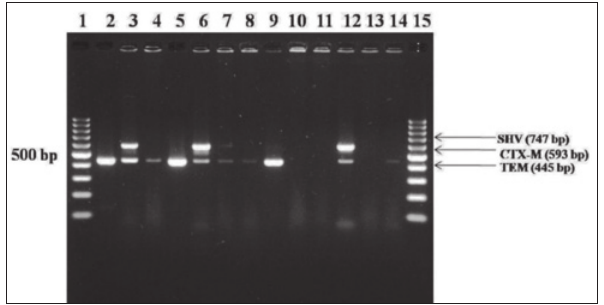
Figu re-1: Escherichia coli isolates from foods of animal origin (chicken meat, chevon meat, and raw milk), human urine and stool samples showing resistance against extended-spectrum β -lactamases antibiotic by multiplex- polymerase chain reaction. Lane 1 and 15: 100 bp ladder, Lane 2 and 5: Positive control, Lane 3, 6, 7, 12: Positive for and bla genes, Lane 4, 9, 14: Positive for bla bla TEM CTX-M gene, Lane 10, 11, 13: Negative E. coli